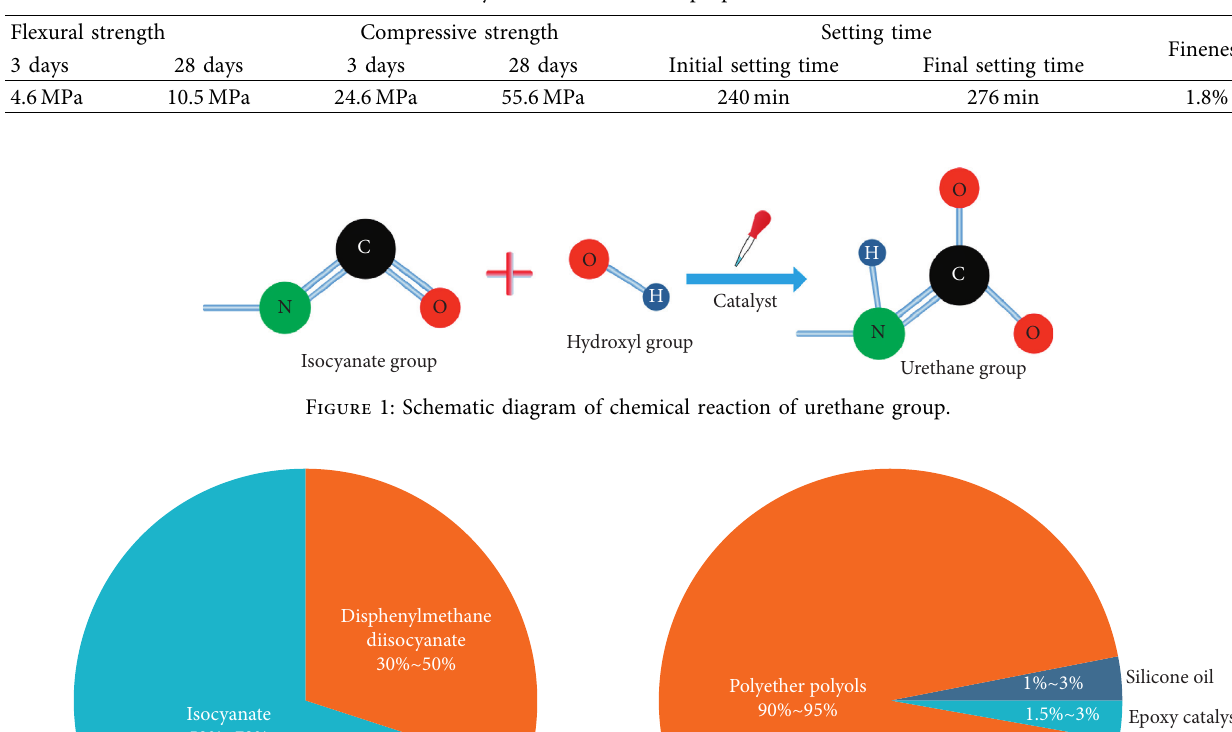
Table 1: Physical and mechanical properties of cement.